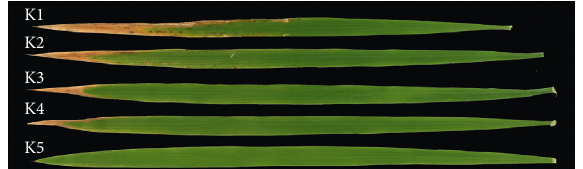
Figure 3: Difference of leaf symptoms under different levels of K